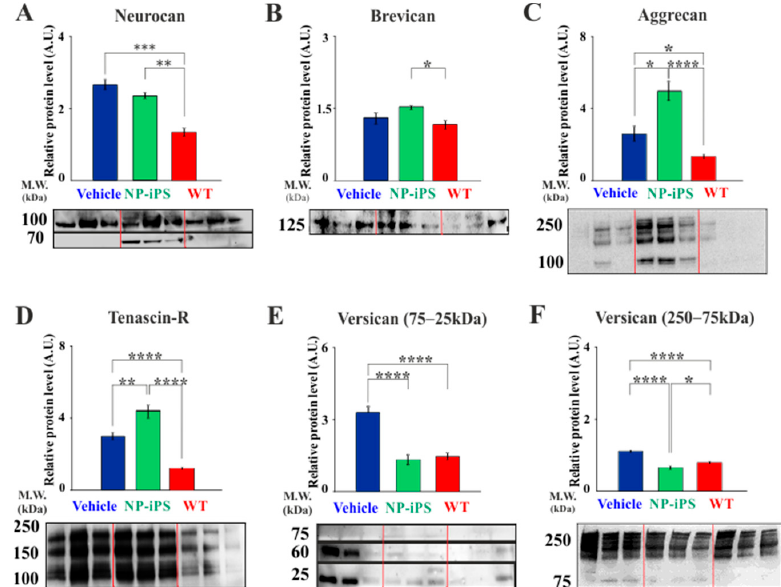
Figure 7. Identification of PNN-related molecules contributing to the disorganized spinal PNN structure. Immunoblotting of gel filtration fractions for the presence of the spinal PNN-related ECM molecules identified the upregulation of neurocan ( A ), aggrecan ( C ), tenascin-R ( D ), and both versican fractions 75–25 kDa ( E ) and 250–75 kDa ( F ); as well as a normal amount of brevican ( B ) in SOD1 animals compared with WT controls. NP-iPS-treated rats showed significantly higher amounts of ECM molecules ( A – D ) than in WT, except for versican ( E , F ), whose levels remained similar to those observed in WT littermates. Di ff erences in the groups were analyzed by one-way ANOVA: statistical significance at p values under 0.05 (*), p < 0.01 (**), p < 0.001 (***) and p < 0.0001